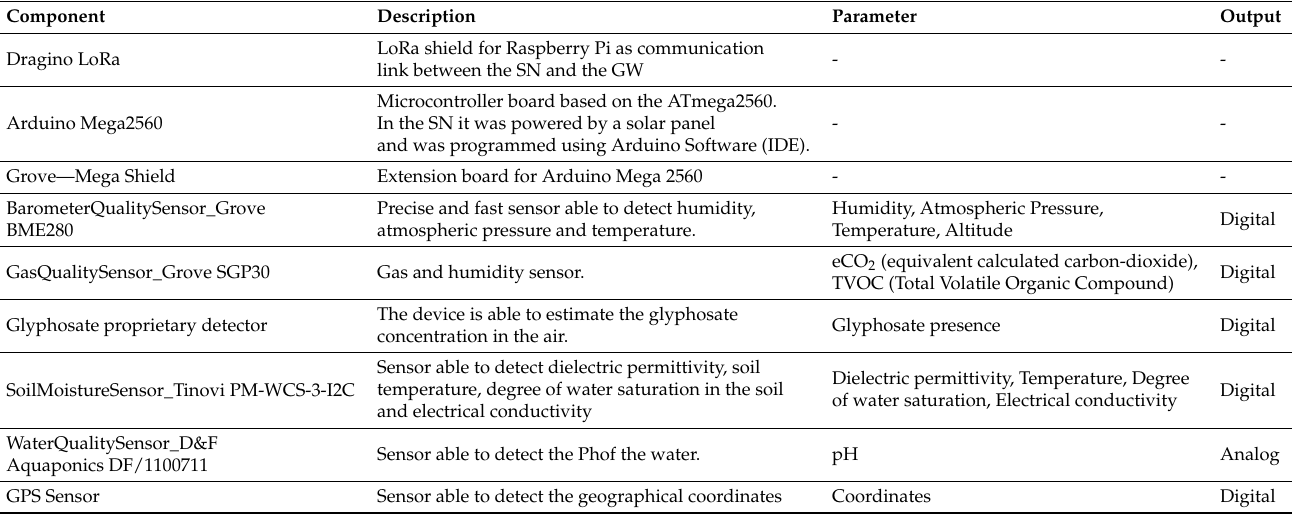
Table 1. Hardware components of the